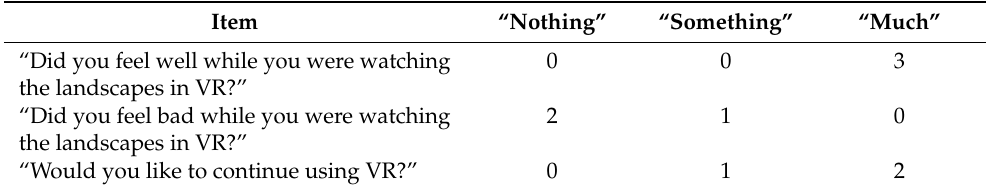
Table 6. Number of responses to each item of the questionnaire developed to register participants’ acceptance of iVR.